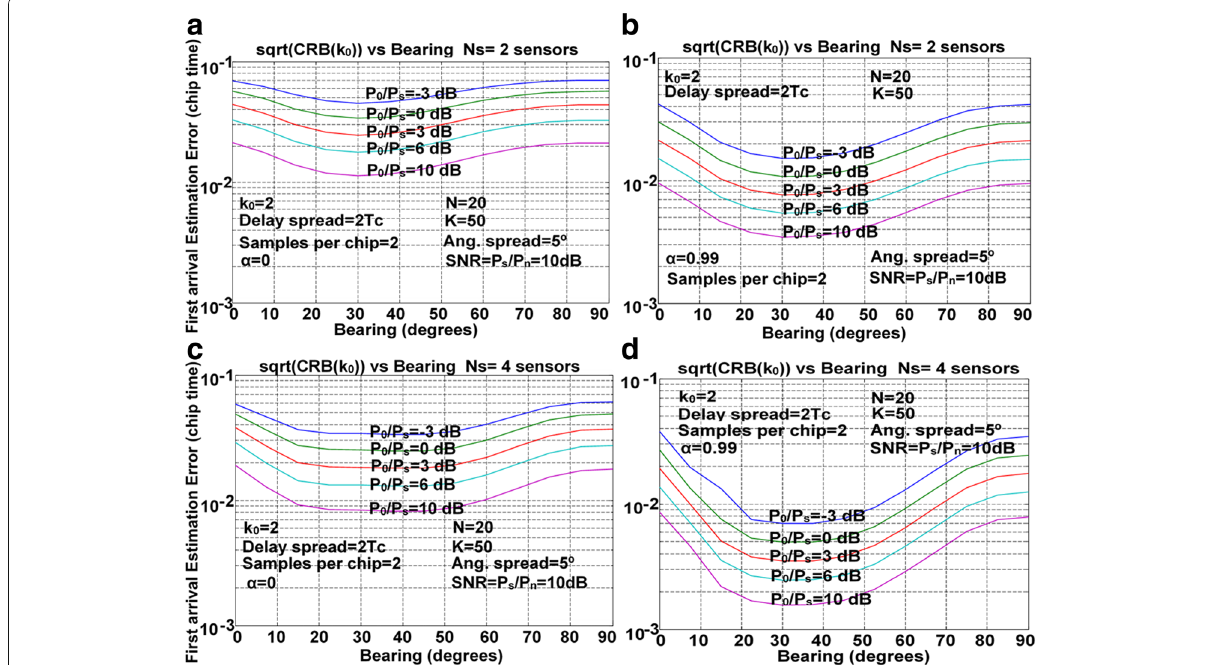
Fig. 10 CRB of the first arriving path k 0 as a function of the signal bearing. Results are provided for different values of the power level of the LOS component and various values of the temporal correlation coefficient α . 50 channel vector estimates are available. The sampling rate set to twice the chip rate, and a roll-off factor of 0.5. Delay spread set to 2 T c , angular spread set to 5° and the dispersed SNR set to 10 dB. a Top left: two sensors—ICD source ( α = 0). b Top right: two sensors—highly temporal correlated source ( α = 0.99). c Bottom left: four sensors—ICD source ( α = 0); d Bottom right: four sensors—highly temporal correlated source ( α =